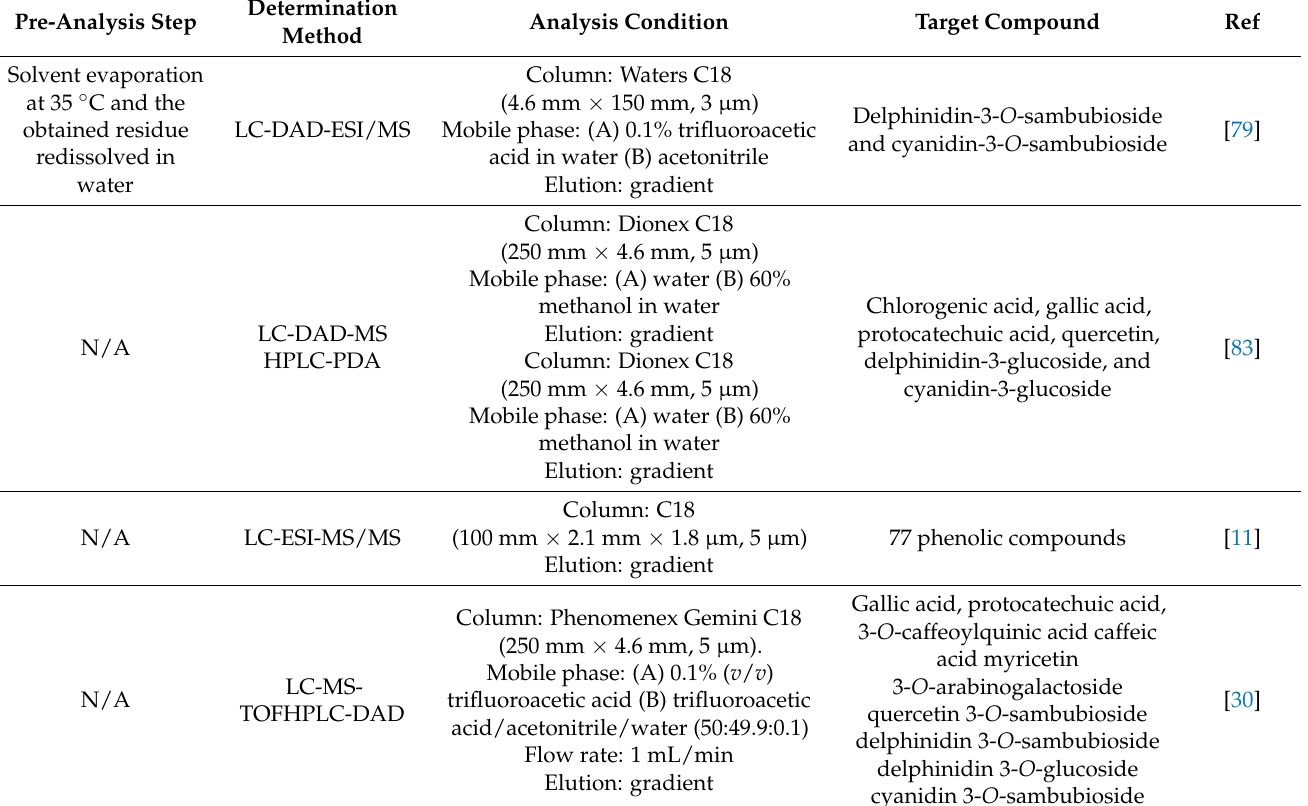
Table 2. Recent chromatography methods to determine the phenolic compounds in roselle calyx. Abbreviations: N/A: not available, LC: liquid chromatography, HPLC: high-performance liquid chromatography, UPLC: ultra-performance liquid chromatography, GC: gas chromatography, TLC: thin-layer chromatography, UV-Vis: ultraviolet-visible, DAD: diode array detector, PDA: photodiode array detector, FID: flame ionization detector, MS: mass spectrophotometry, O: olfactometry, ESI: electrospray ionization, TOF/QTOF: quadrupole time-of-flight, and NMR: nuclear magnetic